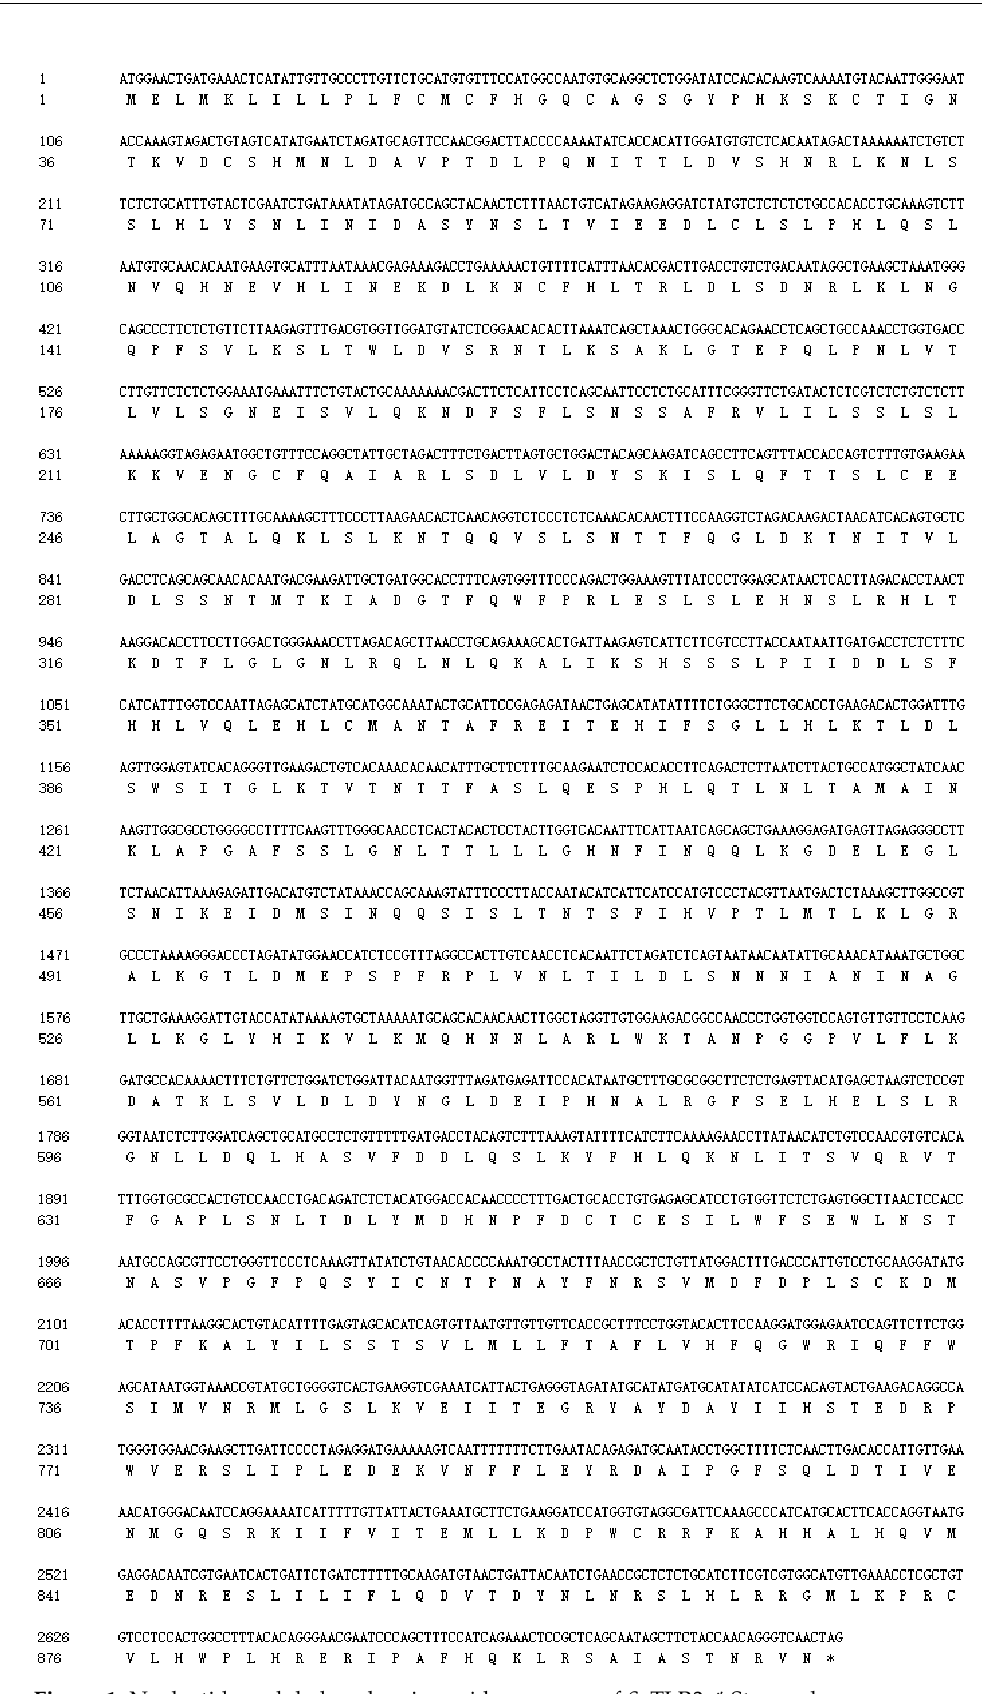
Figure 1. Nucleotide and deduced amino acid sequences of Sp TLR3. * Stop codon.